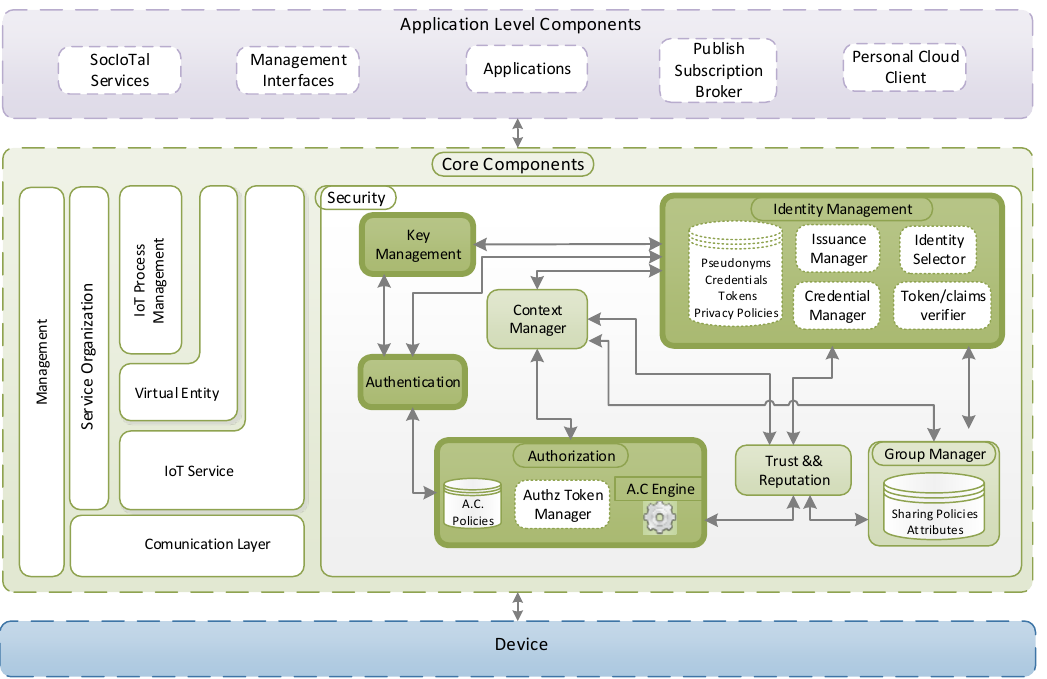
Figure 1. Architectural Reference Model (ARM)-based Security Framework for the Internet of Things (IoT).